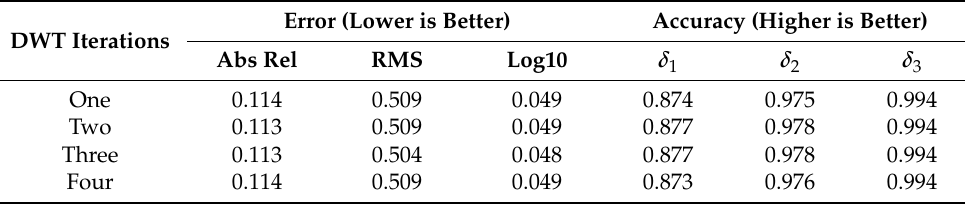
Table 6. DWT iteration effects on the model performance using the wavelet-based loss function.